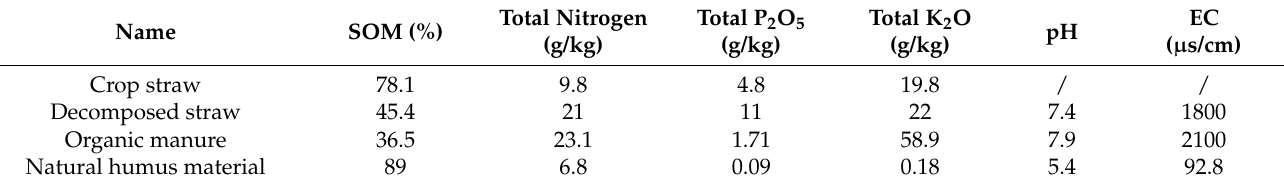
Table 1. Properties of different organic